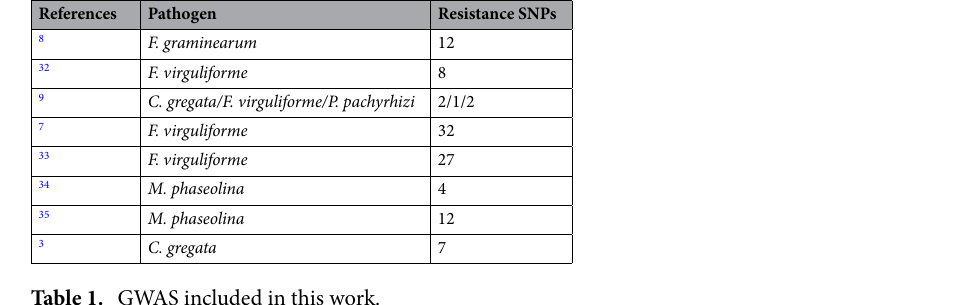
Table 1. GWAS included in this